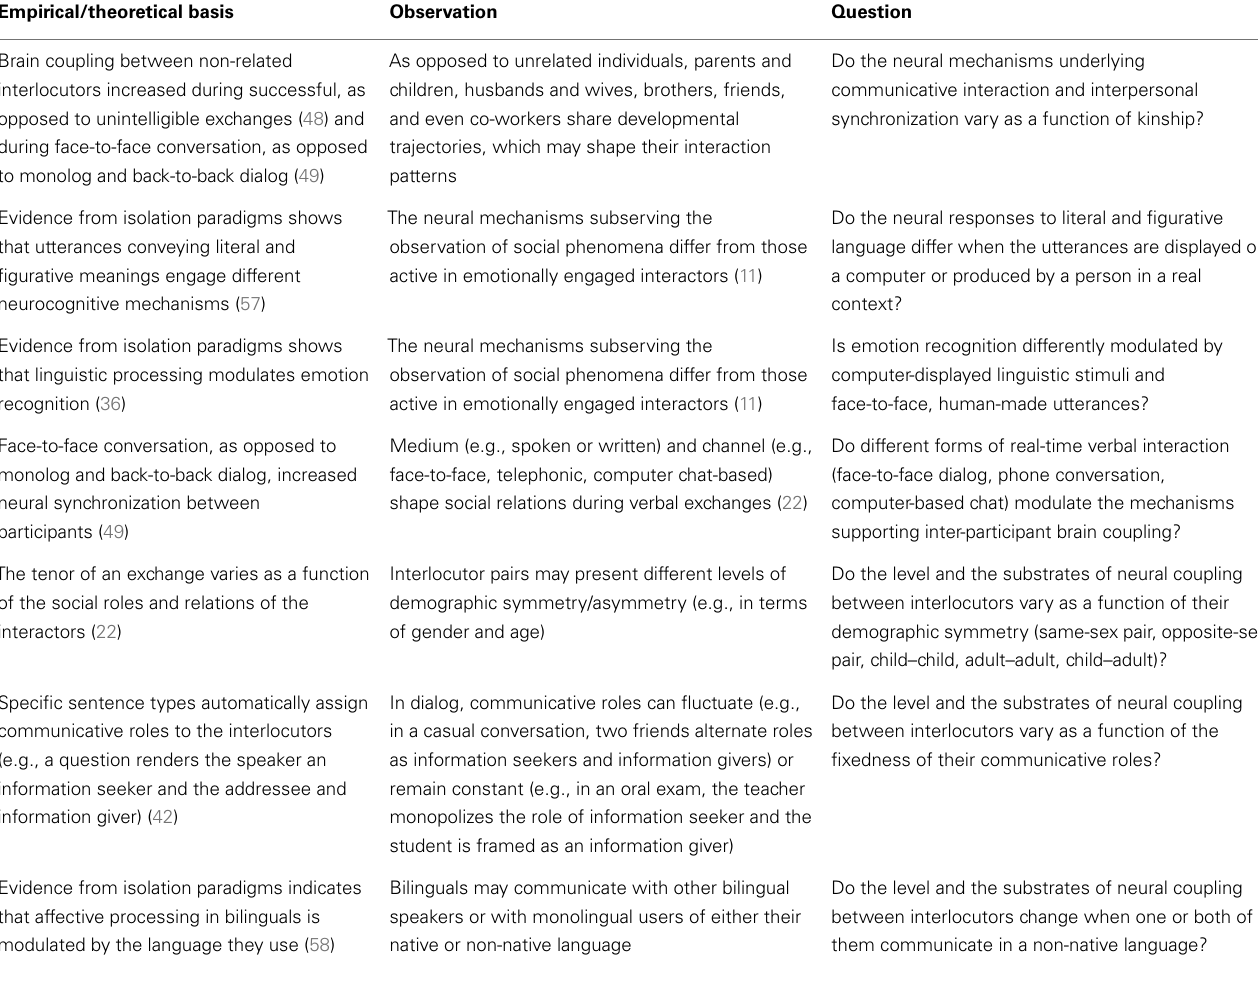
Table 1 | Outstanding questions for future research